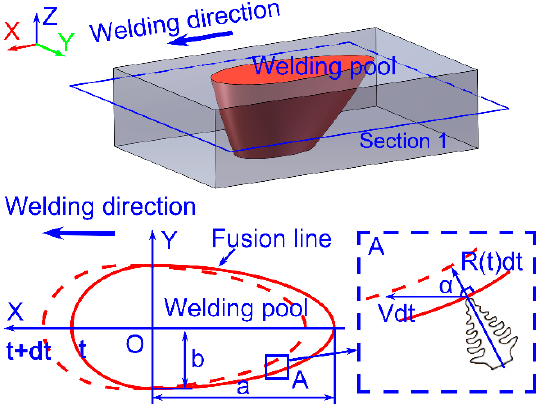
Figure 2. Schematic of the macroscopic welding pool ( upper ), and determination of the temperature gradient and solidification rate along the fusion boundary of welding pool on cross Section 1 ( below ).